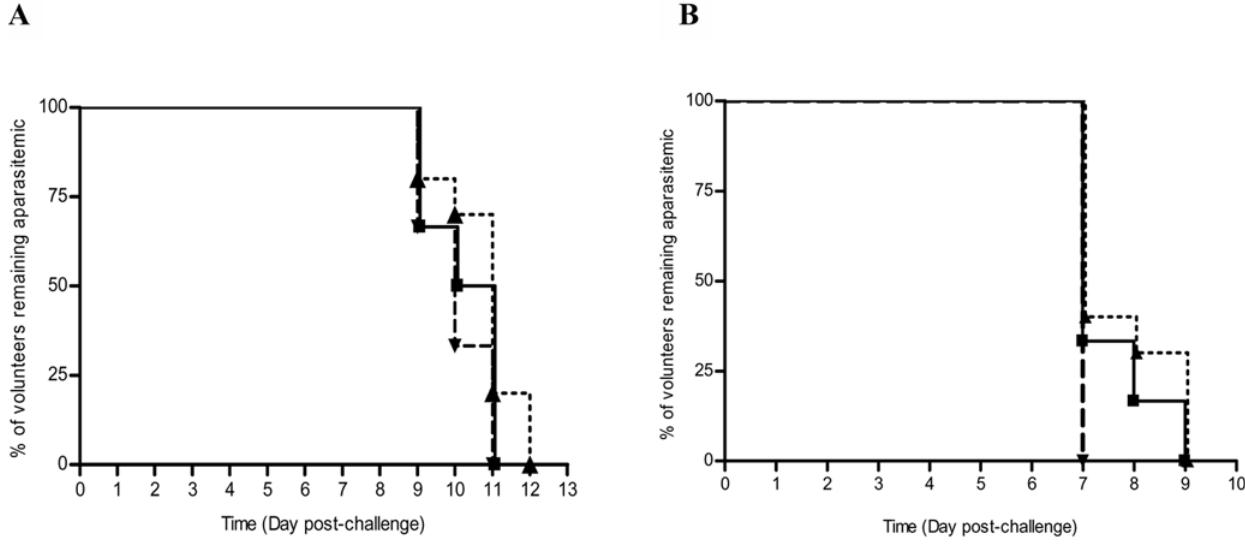
Figure 5. Kaplan-Meier (K-M) Survival Curve for prepatent period. Legend: — Full dose AMA-1/AS01B …… Full dose AMA-1/AS02A – – – Infectivity Controls. (A) Prepatent period by thick blood film. Mean prepatent periods: full dose AMA-1/AS01B 10 days (240 hours), full dose AMA-1/ AS02A 10 days 21 hours (261 hours), infectivity controls 10 days (240 hours), K-M survival curve log rank 2.94, P=0.23. (B) Prepatent period by qPCR. Mean prepatent periods: full dose AMA-1/AS01B 7 days 12 hours (180 hours), full dose AMA-1/AS02A 7 days 17 hours (185 hours), infectivity controls 7 days (168 hours), K-M survival curve log rank 3.25, P=0.19.